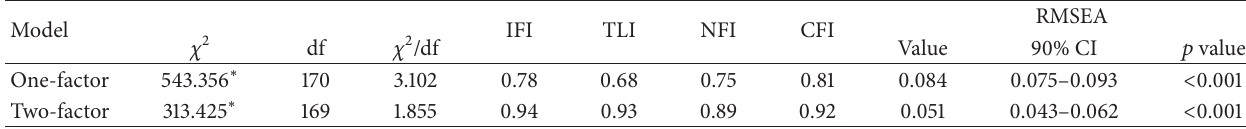
Table 3: Goodness of fit summary for one- and two-factor